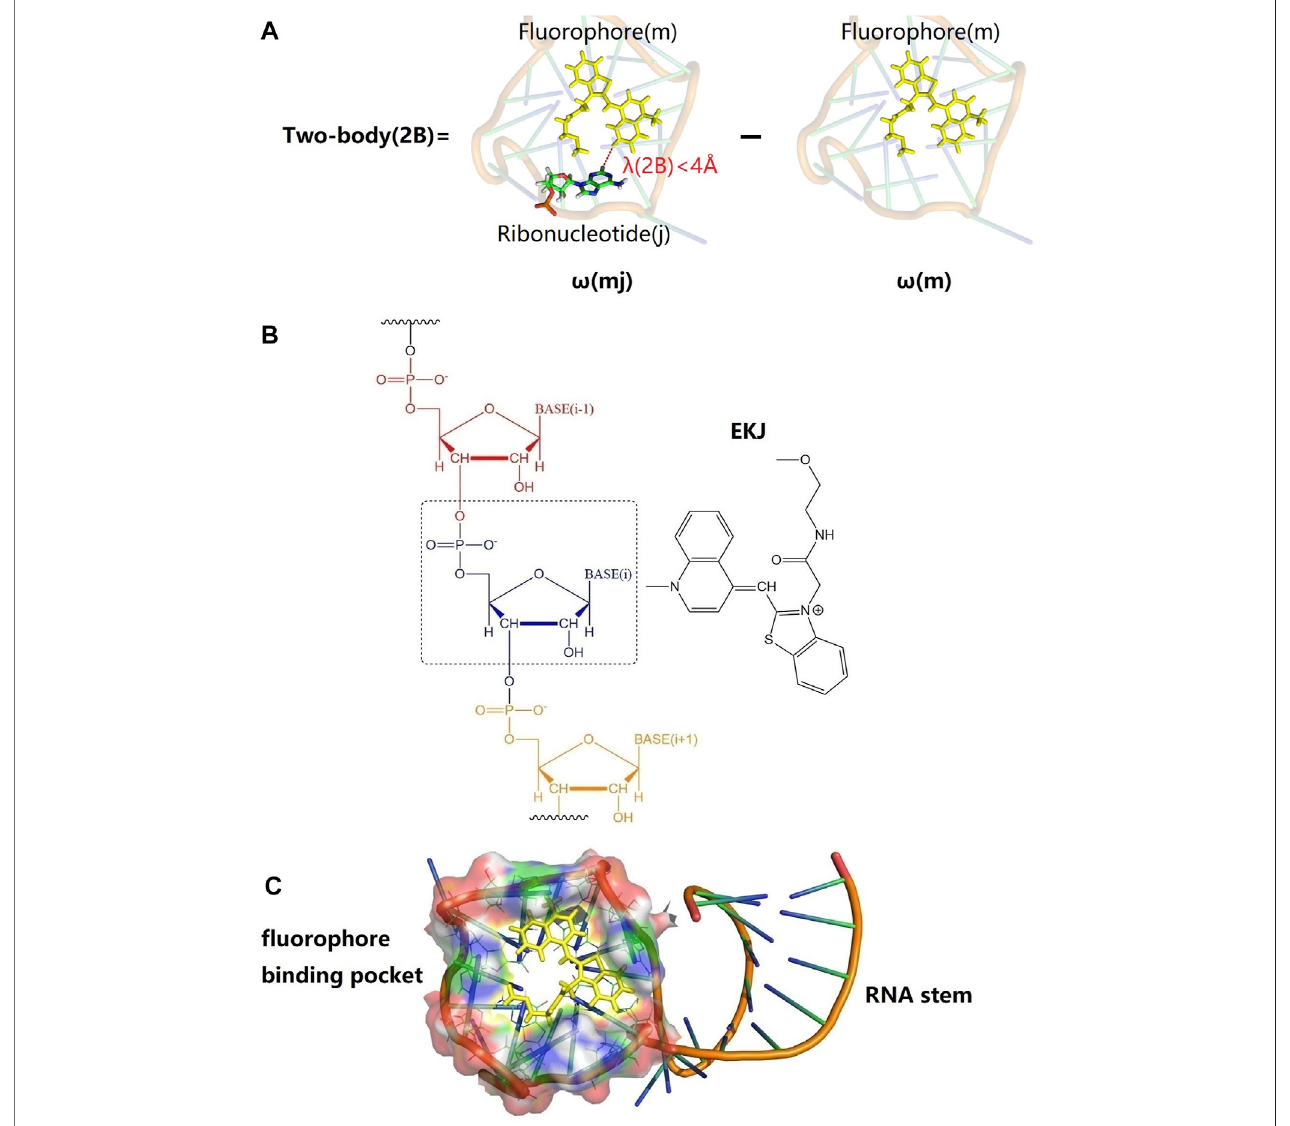
FIGURE 1 | Graphical representations of fl uorophore (EKJ) and Mango II RNA aptamer (PDB id: 6C63) and illustration of the two-body (2B) treatment of the excitationcalculationintheEE-GMFCCfragmentationmethodforRNAsystems. (A) Anexampleof2Bcalculation;theyellowstickrepresentsthelocallyexcitedregionof the fl uorophore( m ).A22isaribonucleotideintheRNA,whosespatialdistancefromthe fl uorophoreiswithinaprede fi nedthresholdof λ (2B)(here4 (cid:1) Awasemployed). (B) TheEE-GMFCCschemewherethebondiscutforthe i thribonucleotide(inblackdottedbox),andthe i thfragmentwasutilizedintwo-bodyQMcalculationwiththe EKJ. (C) Mango II-EKJ complex. Mango II RNA consists of two parts: a stem and fl uorophore-binding pocket.